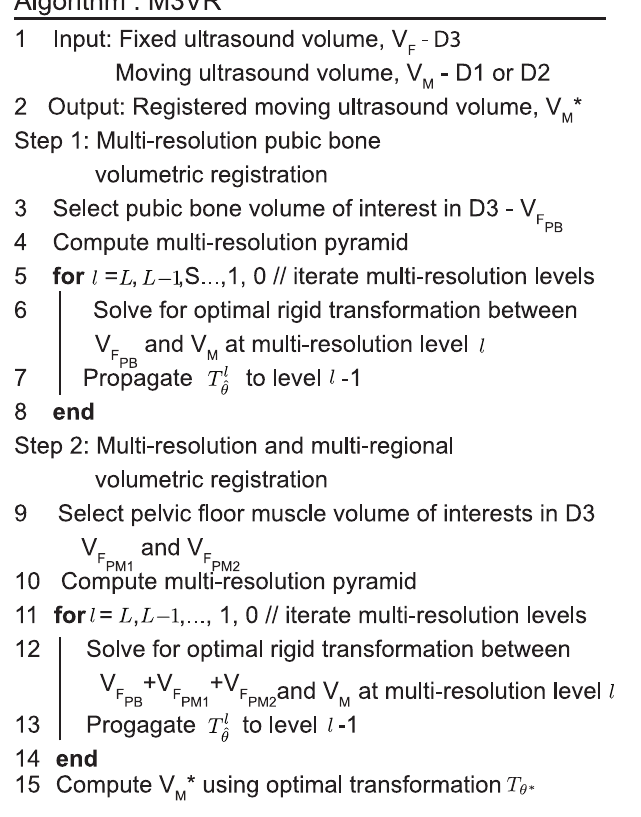
Fig 3. Algorithm of M3VR. Two-stage multi-resolution volume registration. Stage 1: pubic bone sub-volume registration. Stage 2: spatially weighted multiple sub-volumes registration on pubic bone and pelvic floor muscles.